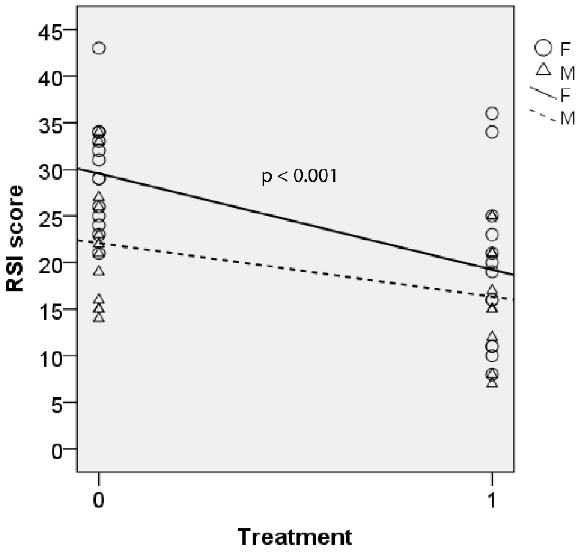
Figure 5. RSI scores before and after BTX therapy with linear trend lines for male (M) and female (F). Lower score indicates better outcome. 0 = baseline; 1 = post-BTX treatment.